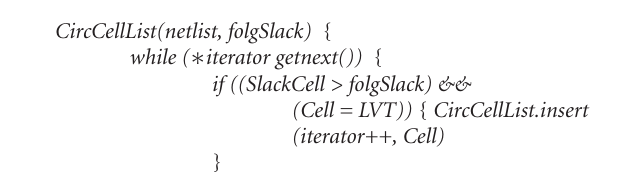
Algorithm 1: The pseudocode for the creation of the circCellList .